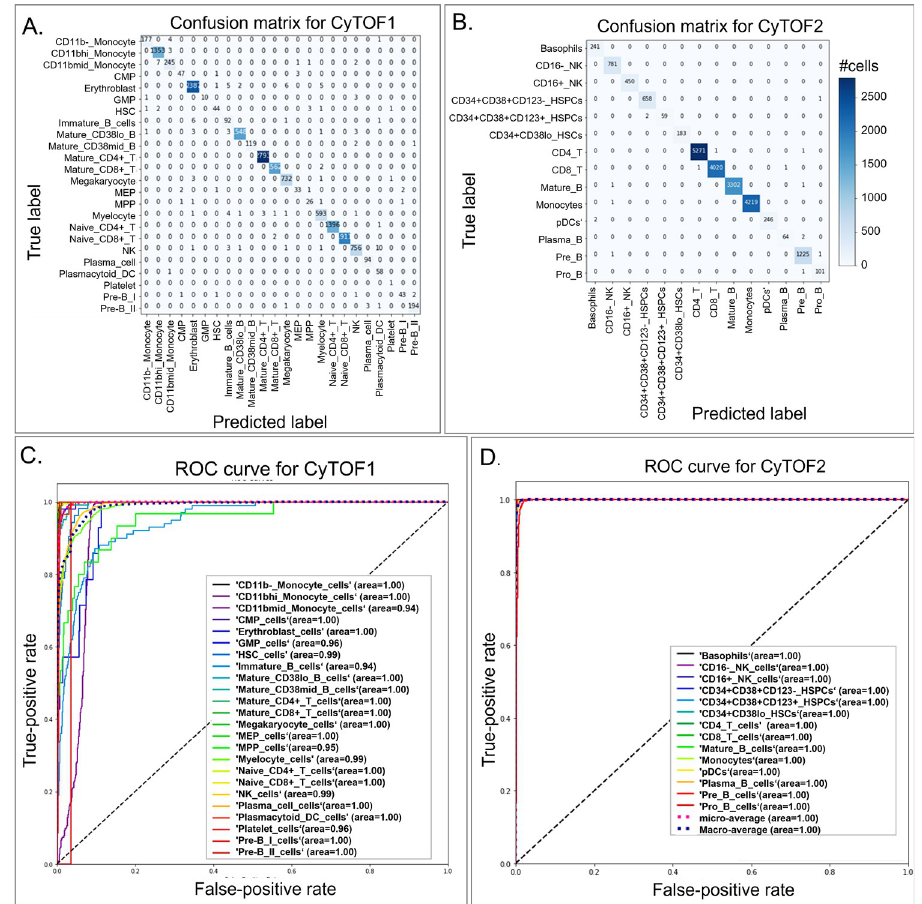
Fig 3. Comparison of confusion matrices and their associated receiver operating characteristic (ROC) curves for real labels of CyTOF1 and CyTOF2 datasets as assessed utilizing the DGCyTOF model. ( A , B ) confusion matrices for the ( A ) CyTOF1 dataset and ( B ) CyTOF 2 dataset; ( C , D ) ROC curves for the ( C ) CyTOF1 dataset and ( D ) CyTOF 2 dataset. algorithm. Each row of the matrix represents the instances in an actual class, and each column represents the instances in a predicted class (or vice versa). For example, our algorithm cor- rectly assigned 12057 of 12065 cells in our validation data as CD8-T cells and the other eight incorrectly, as CD4-T, CD16-NK, and Plasma-B cells ( Fig 3A and 3B ). We applied a ROC metric to evaluate the quality of classifier output using 4-fold cross-validation between the true and prediction labels ( Fig 3C and 3D ). Results showed the average performance in the two testing datasets, with 71.9 to 99.4% accuracy and average ROC area of 0.94 to 1.00 in CyTOF1 and 96.5 to 99.8% accuracy and average ROC area of 1.00 in CyTOF2.We compared all predic- tion results for combination methods with true labels, employing four evaluation criteria to compare the performance of the DGCyTOF and DeepCyTOF methods [37] in classifying labeled data in the CyTOF1 and CyTOF2 databases: F- score (harmonic mean of precision and recall) [11]; ARI (adjusted Rand index, a measure of similarity between two clusters) [59]; FMI (Fowlkes-Mallows scores) [55]; and V-measure (harmonic mean between homogeneity and completeness) [51]. Table 3 shows the comparison results. All cell-type classifiers used in the DeepCyTOF model were depth-4 feedforward nets, with softplus hidden units and a softmax